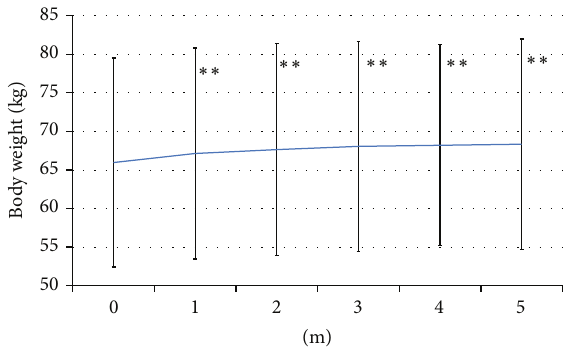
Figure 2: Changes of body weight. Weight gain occurred from 1 month after switching therapy. ∗∗ 𝑃 < 0.01